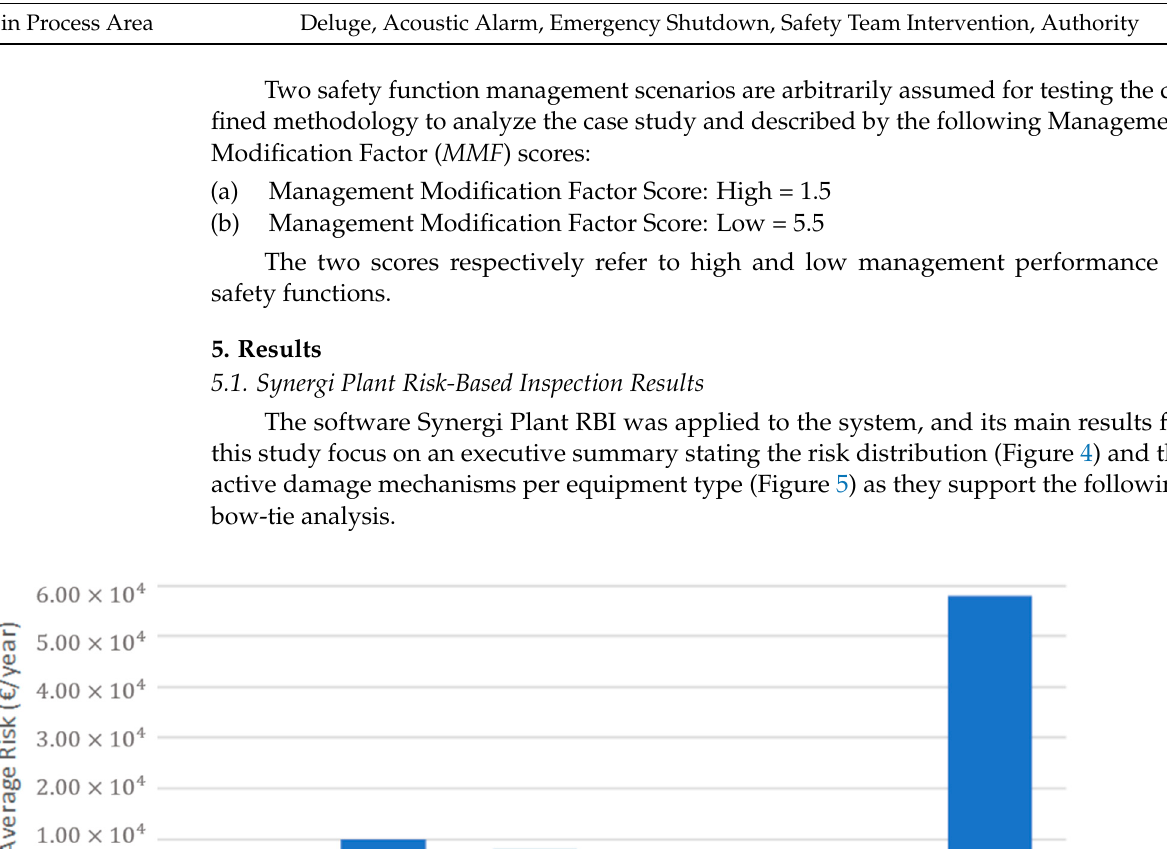
Figure 5. Active Damage mechanisms per equipment of the Oil Production Unit. DF stands for Damage Factor, and SCC stands for Stress Corrosion Cracking. 02040 60